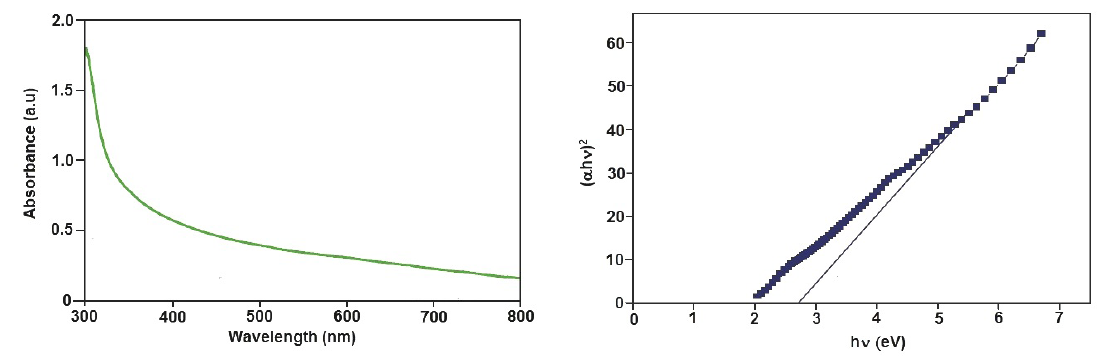
nanoparticles Fig.7. Plot of (αhν) 2 Vs photon 2